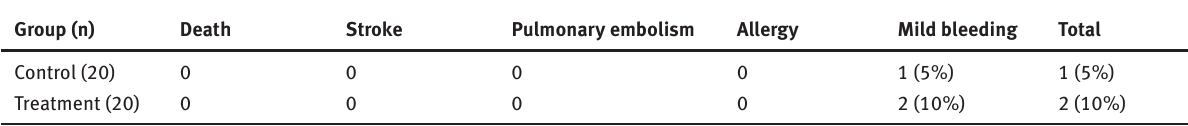
Table 6: Comparison of the incidence of adverse reactions after treatment between the patient groups [n (%)] Group